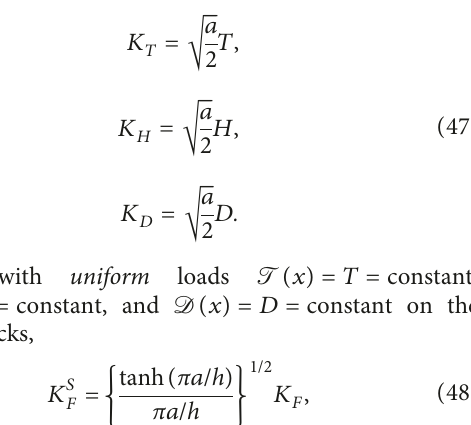
Figure 3: Variation of the normalized field intensity factors with the relative spacing in a stack of uniformly loaded